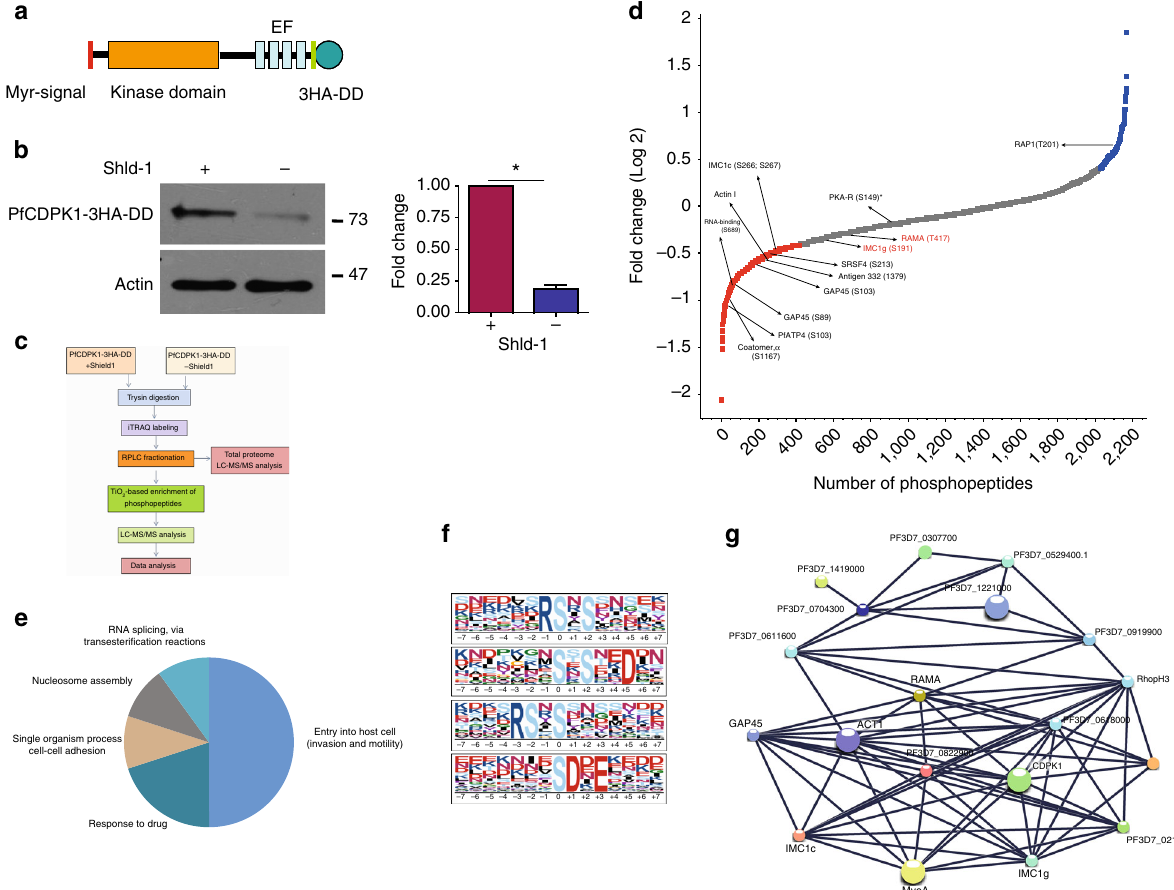
Fig. 1 Identi fi cation of putative PfCDPK1 substrates and interacting proteins. a PfCDPK1-3HA-DD parasites were generated by fusing the C-terminus of PfCDPK1, with an FKBP Death Domain (DD) and HA tag (Supplementary Fig. 1). PfCDPK1 possesses a N-terminal myristoylation and palmitoylation motif (red) and a C-terminal calmodulin like domain. The DD domain targets PfCDPK1 to proteasomic degradation in the absence of its ligand Shld-1. b PfCDPK1-3HA-DD parasites were cultured in the presence (+) of Shld-1. At the ring stage, parasites were split and Shld-1 was removed ( − ) from one half of the cultures. The cultures were harvested at the schizont stage and western blotting was performed using anti-HA antibody to detect the expression of PfCDPK1-3HA-DD. Actin was used as the loading control. Right Panel , Densitometry was performed for PfCDPK1 bands and was normalized with respect to the loading control (Mean ± s.e.m., * n = 3, p < 0.0001, t -test). c Schematic illustrating the work fl ow followed for quantitative proteomics and phosphoproteomics studies from